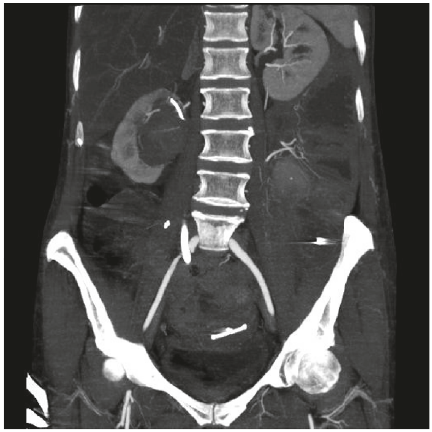
Figure2:Abdominal-pelvicCTscanfrontalcutpassingthroughthe right ureter: endoureteral balloon probe in place in the right ureter at the fistula with the right primary iliac artery.